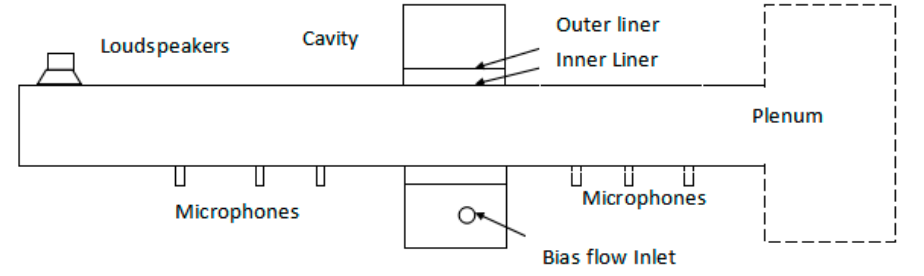
Figure 6. Test rig setup in the experiment by Eldredge and Dowling